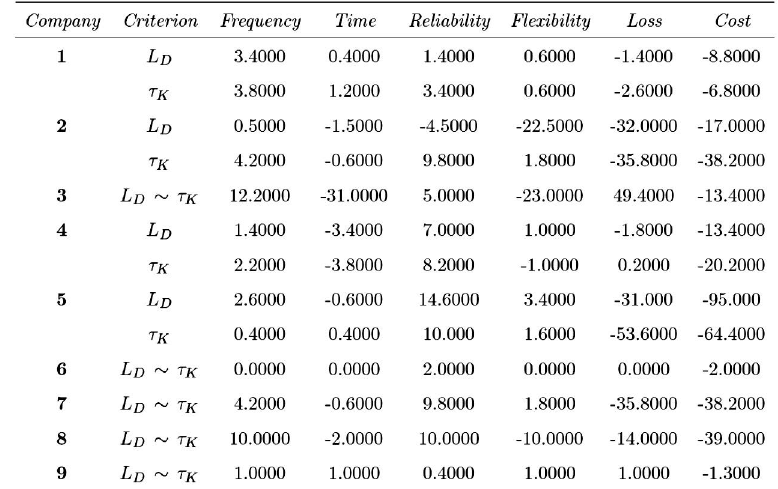
Values taken by  parameters for each